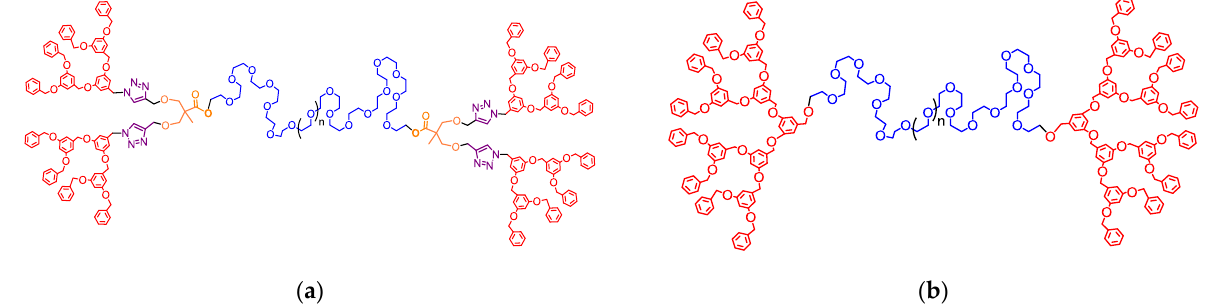
Figure 4. Structures of linear dendritic block copolymers containing the same amount of poly(benzyl ether) dendrons attached to the same PEG block (n = 233): ( a ) (G2) 2 − PEG11k − (G2) 2 , this work; ( b ) [G-3] − PEG11k − [G-3], [1,6].